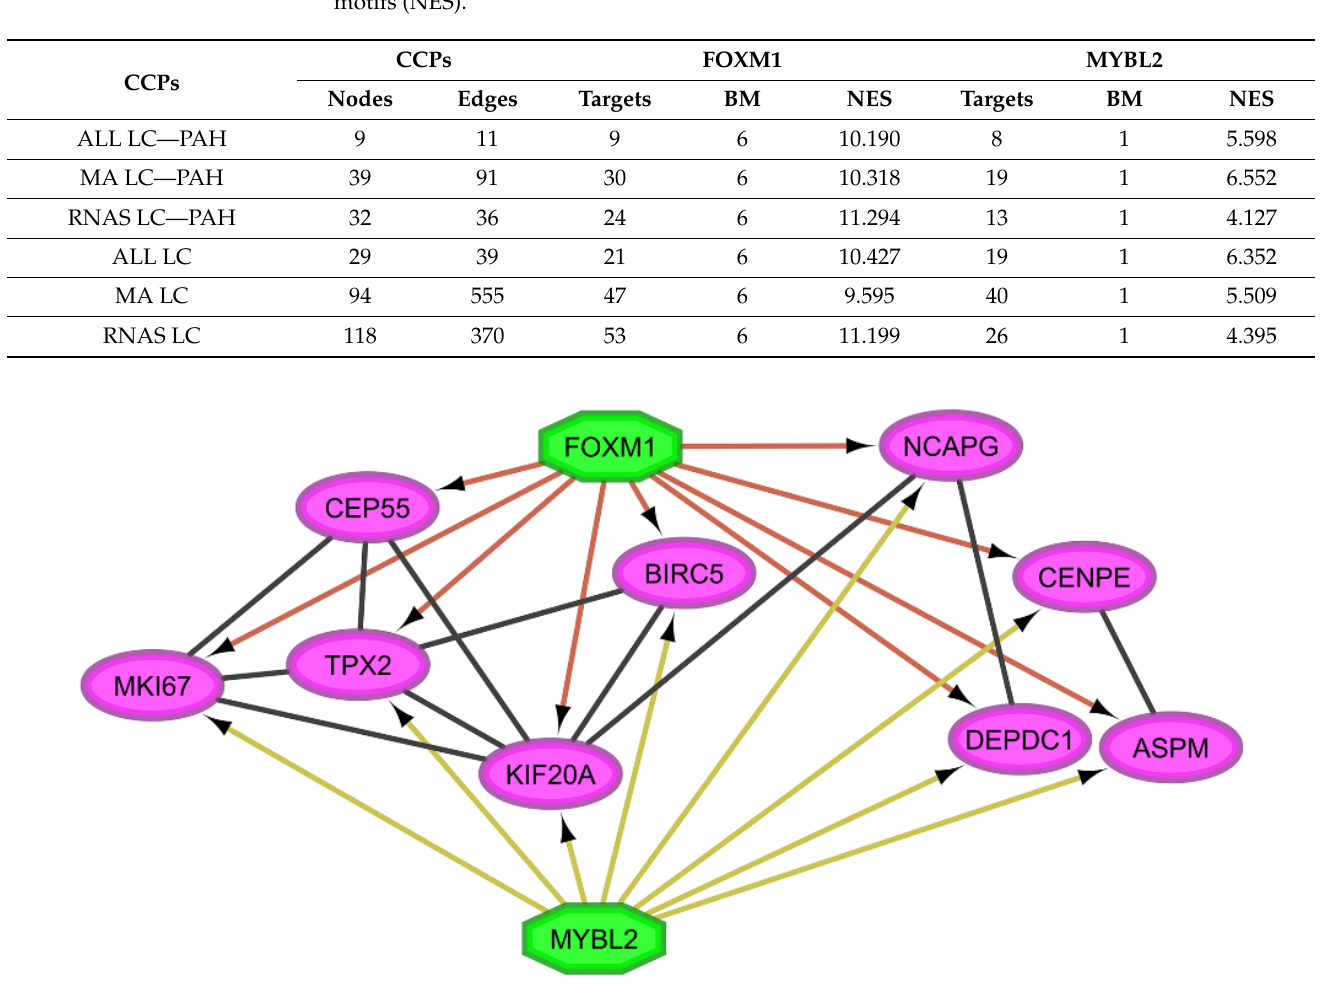
Table 3. Common connection patterns (CCPs) of lung cancer (LC) (microarrays (MA) and RNA- Seq (RNAS)) and pulmonary arterial hypertension (PAH), iRegulon main regulators (FOXM1 and